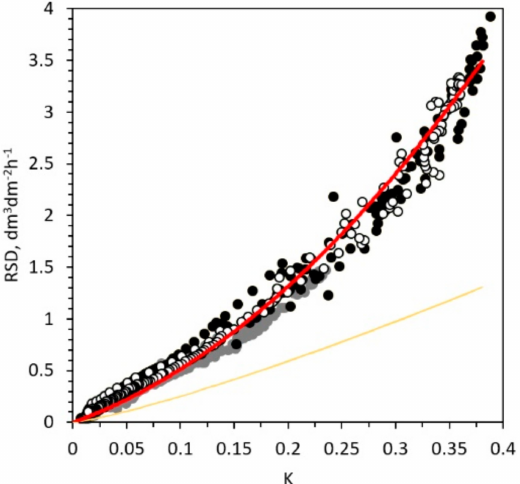
Figure 4. Relationship between k Equation (1) and reference sap flow density (RSD: Black dots: Day 177; grey dots: Day 198; white dots: Day 240). The red line is the species-specific calibrated model Equation (5), the yellow line represents the original Granier